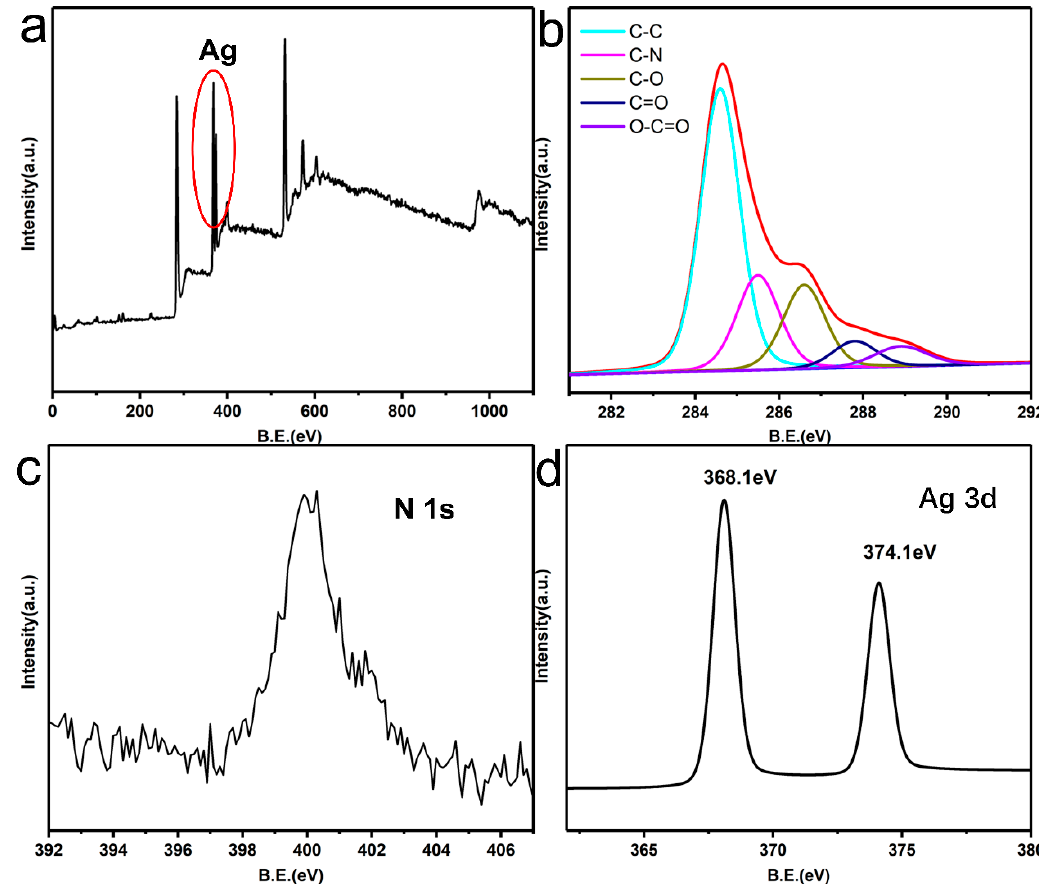
Figure 3. Raman spectra ( a ), XRD pattern ( b ) of GO, PDA-RGO, and Ag-PDA-RGO, and the optical picture ( c ) of GO (1), PDA-RGO (2), and Ag-PDA-RGO (3) aqueous solution. FTIR spectra ( d ), UV– visible spectra ( e ) of GO, PDA-RGO, and Ag-PDA-RGO. Atomic force microscopy (AFM) image ( f ) of Ag-PDA-RGO.